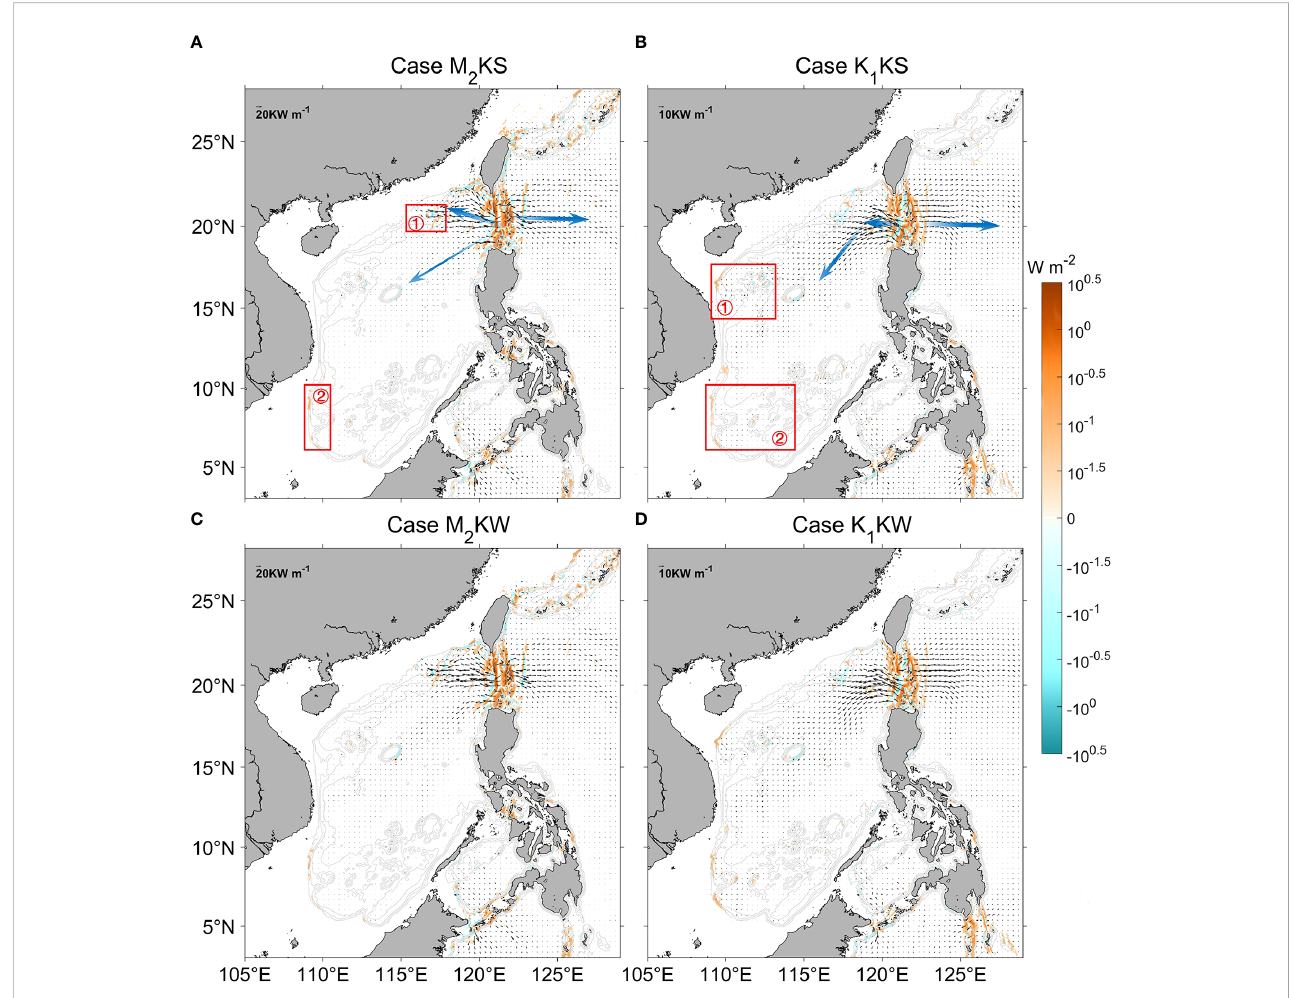
FIGURE 5 Modeled depth-integrated and period-averaged internal tide energy fl ux (black arrows, kW m -1 ) and conversion rate (color, W m -2 ) for with-Kuroshio cases. (A) Case M 2 KS. Gray contours are isobaths. Blue arrows indicate energy beams. Red boxes marked ① and ② show the main areas of internal tide generation within the SCS. (B) Case K 1 KS. (C) Case M 2 KW. (D) Case K 1